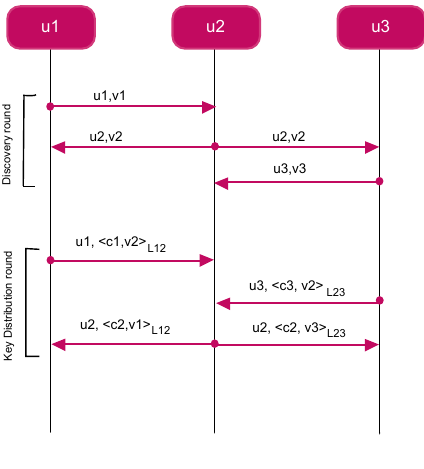
Figure 7. The CKDP applied to